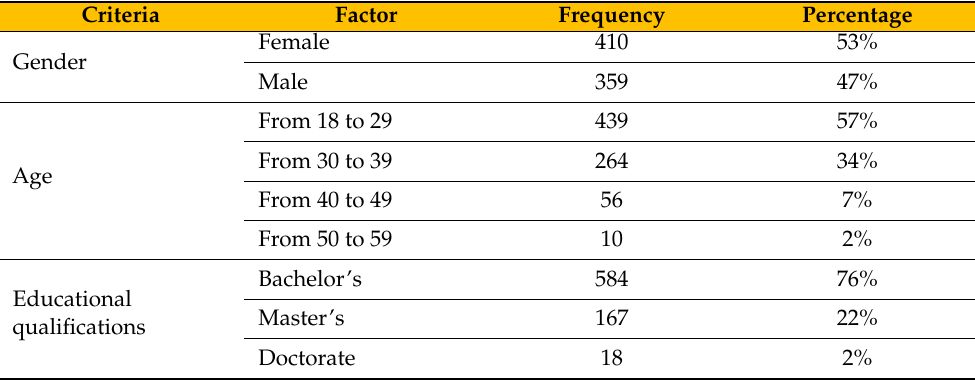
Table 1. Demographic data for the